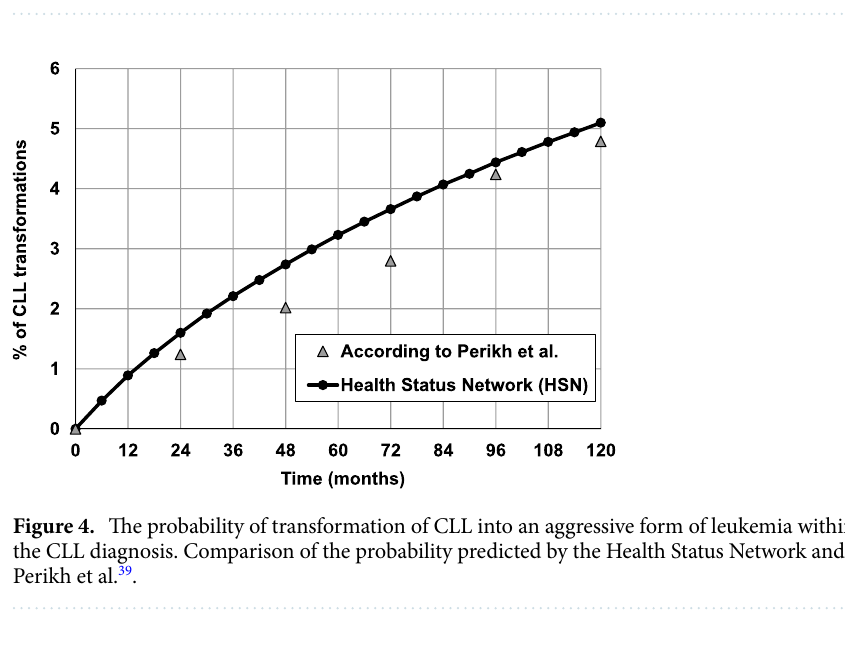
Figure 3. Percentage of patient with CLL alive within 60 months from diagnosis. Survival of patients with CLL predicted by the Health Status Network (HSN) and Treatment Effect Network (TEN) in comparison with results collected in SEER*Stat 35,36 and EUROCARE-5 databases 37,38 .